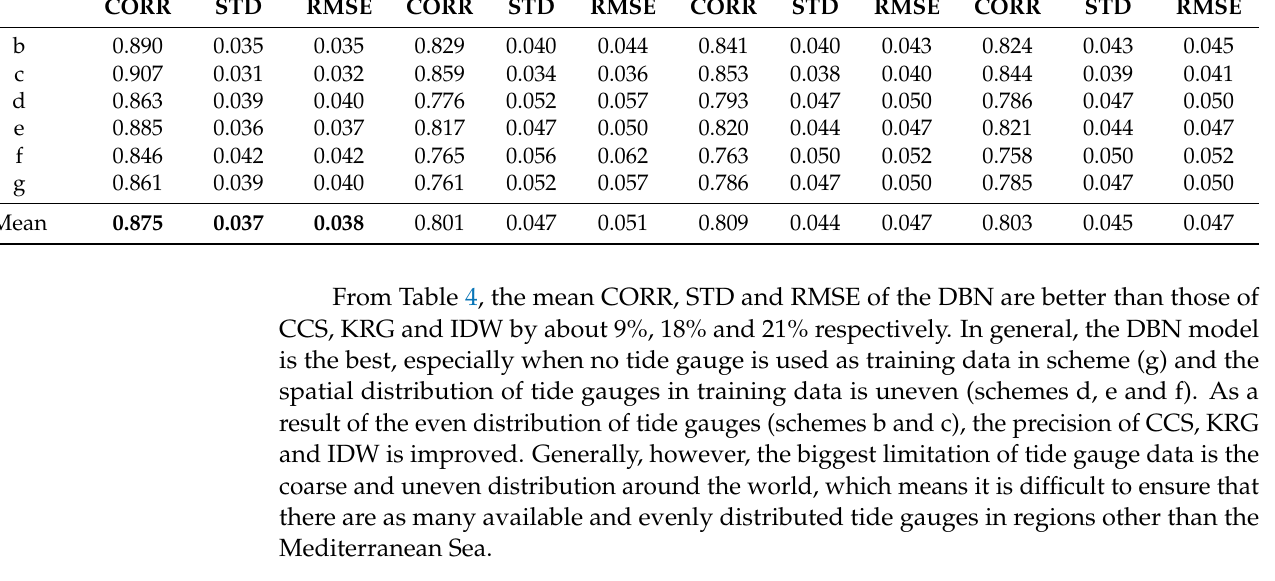
Table 4. Statistics of the four methods in six schemes with altimetry-derived along-track SLAs (m).